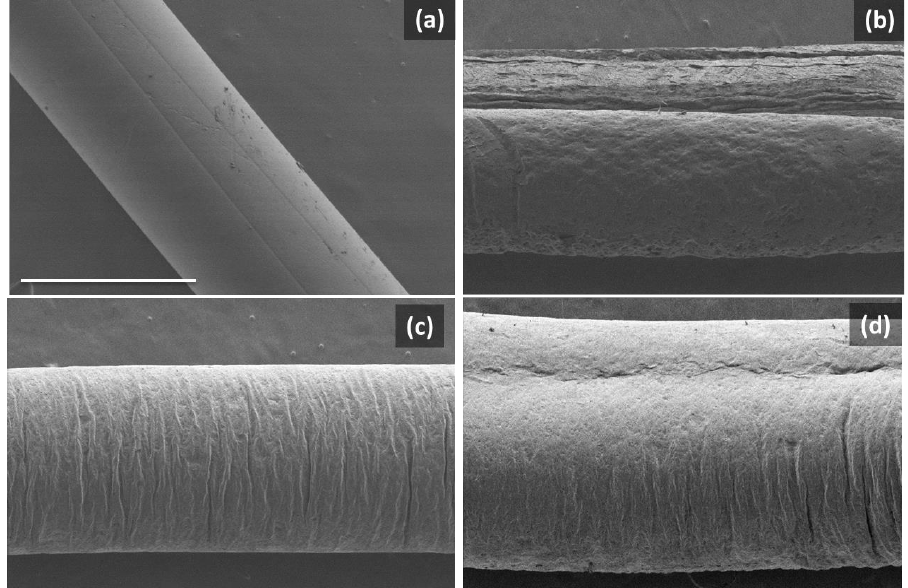
Figure 4. SEM images of the surfaces of dry-jet-wet-spinning-produced fibers: ( a ) PET and PET/graphene with loadings of ( b ) 2 wt.%, ( c ) 4 wt.% and ( d ) 5 wt.%. Scale bar in ( a ) applies to all images and corresponds to 500 microns.